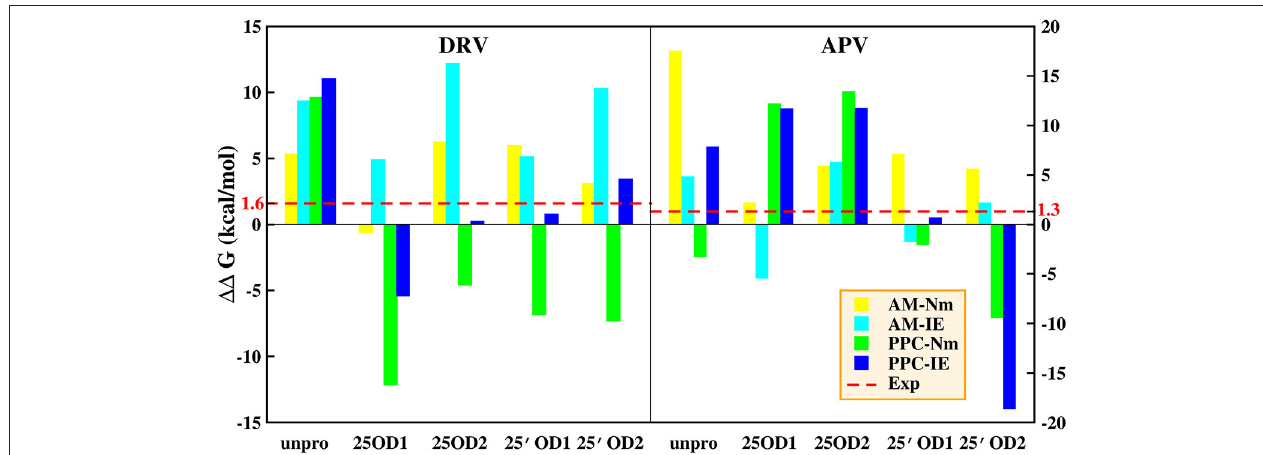
FIGURE 4 | Difference between binding free energy of PR1 complex and binding free energy of PR2 complex. AM represents AMBER; Nm represents Nmode. Cyan lines represent experimental values. *The experimental value is calculated by Weber ( Tie et al., 2012).